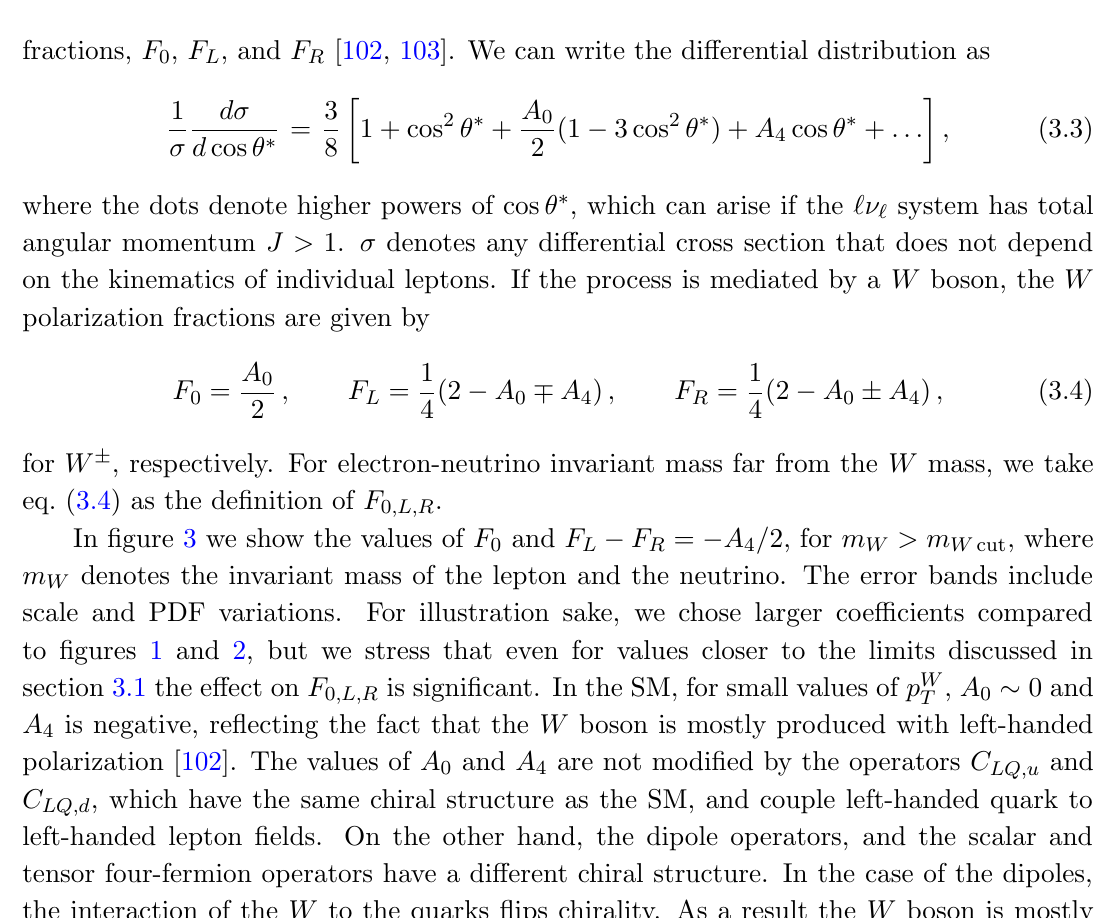
Figure 3 . Polarization fractions F 0 and F L (cid:0) F R in pp ! e + (cid:23) e , for m W > m W cut , where m W denotes the invariant mass of the neutrino and charged lepton, at indicate the uncertainties from PDF and scale